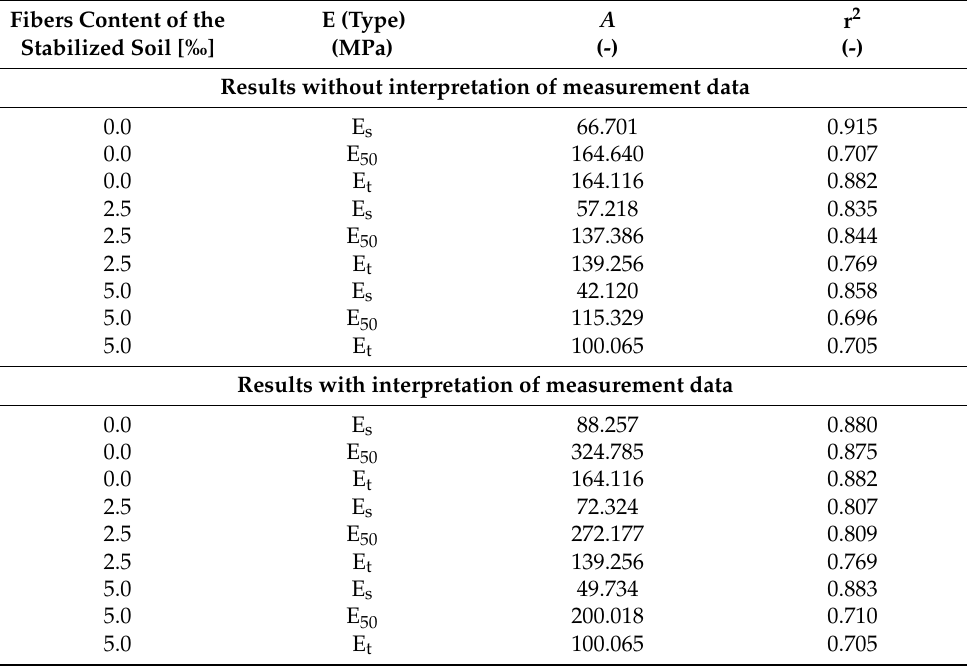
Table 9. Parameter A for determining the prediction of modulus values for stabilized soils.